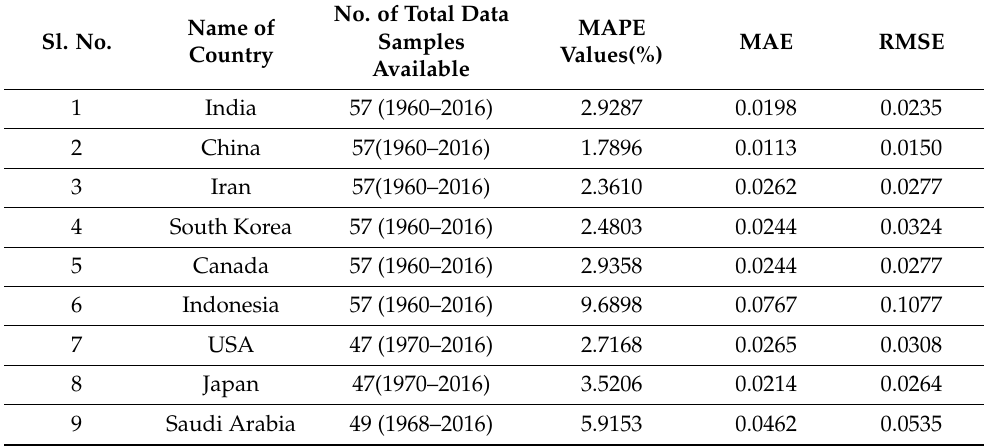
Table 2. MAPE, MAE and RMSE values obtained during testing for Group-1 countries.